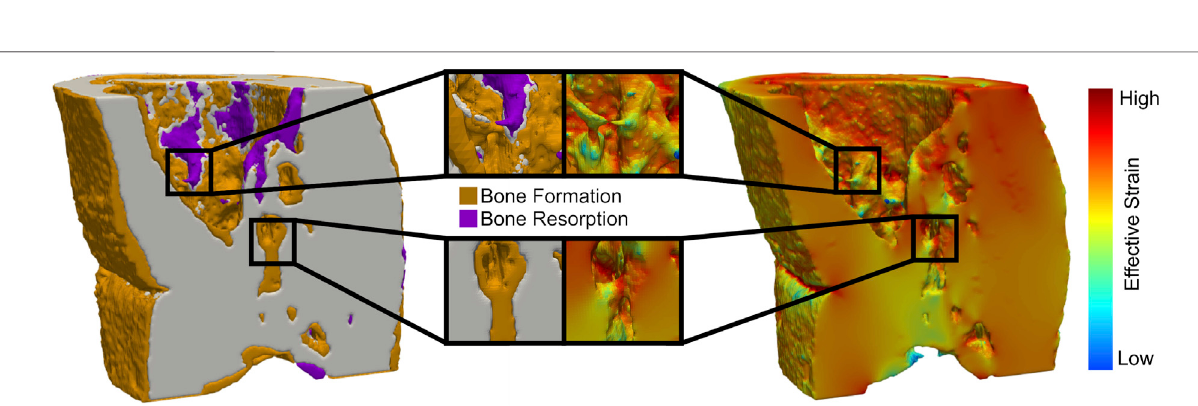
Frontiers in Cell and Developmental Biology |